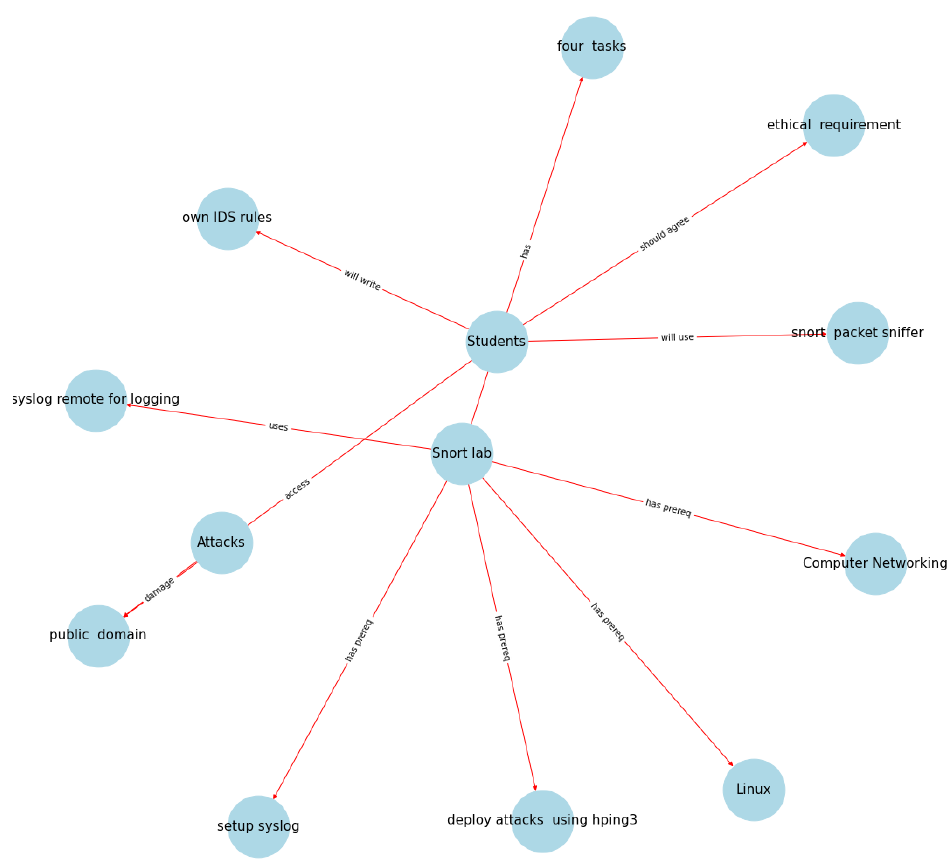
Figure 2. Prelim graph generated from entities and relations extracted using named-entity recogni- tion (NER) as subject–object pairs and predicates in Section 3.1.2. This graphical representation of unstructured text has redundant data, but it is still helpful for the domain expert in visualizing